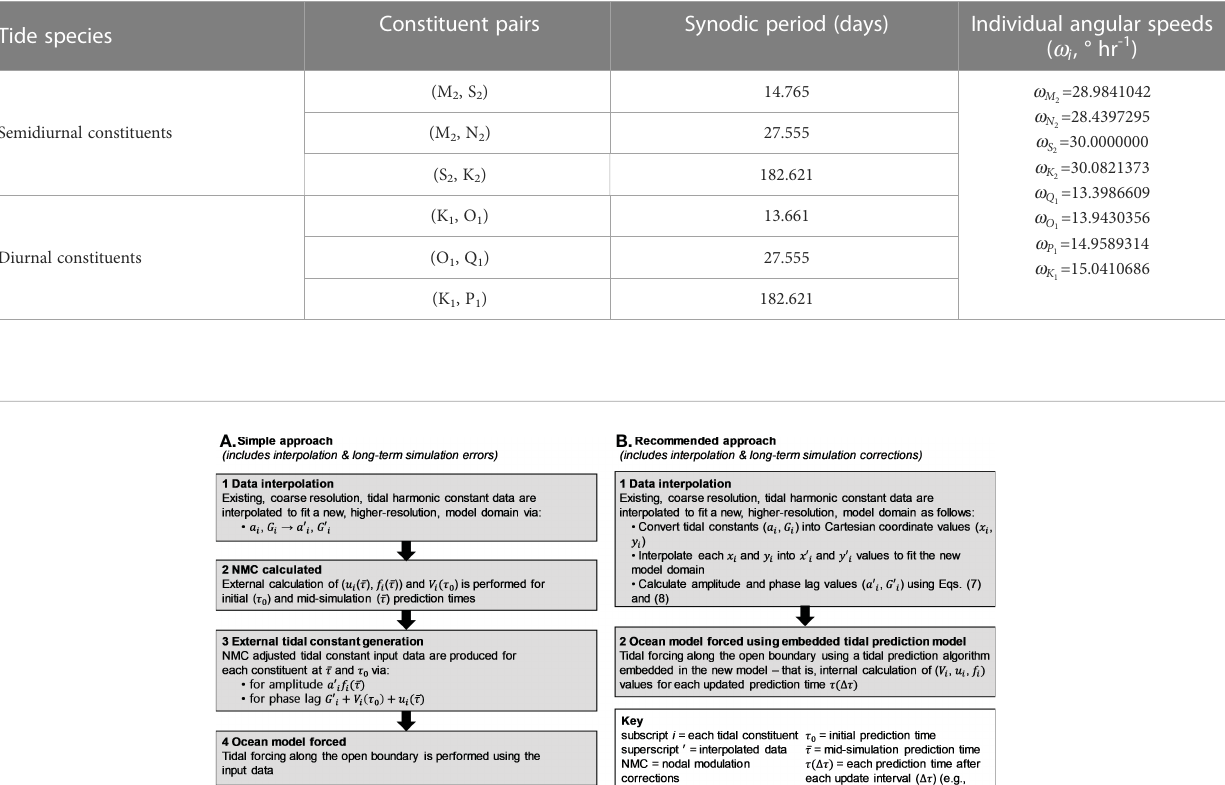
TABLE 2 Key pairs of neighboring semidiurnal and diurnal constituents and their synodic periods (which correspond to the modeled sea level dataset durations required to separate out paired constituents via conventional harmonic analysis), and individual constituent angular speeds.